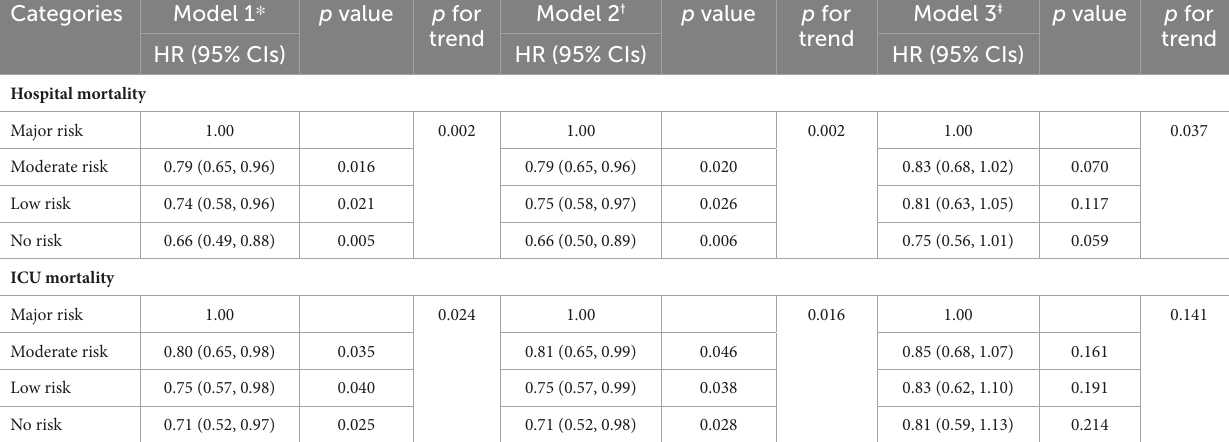
TABLE 2 Cox proportional hazard models of the relationship between GNRI and all-cause mortality. Categories